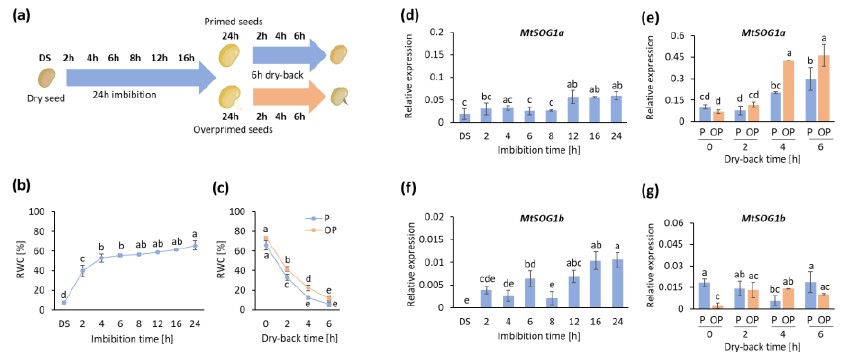
Figure 6. ( a ) Experimental design for the seed priming/over-priming system. Dry seeds and imbibed seeds were collected at 2 h, 4 h, 6 h, 8 h, 12 h, 16 h, and 24 h of imbibition. Subsequently, primed and over-primed seeds were collected at 24 h of hydropriming and during dry-back at 2 h, 4 h, and 6 h. ( b ) Percentage (%) of relative water content (RWC) during seed imbibition. ( c ) Percentage (%) of relative water content (RWC) during seed dry-back. Relative gene expression profiles of MtSOG1a ( d ) during seed imbibition and ( e ) priming (P)–over-priming (OP). Relative gene expression profiles of MtSOG1b ( f ) during seed imbibition and ( g ) priming (P)–over-priming (OP). Data were analyzed with two-way ANOVA and Tukey–Kramer test, where means without common letters are considered significantly different ( p <